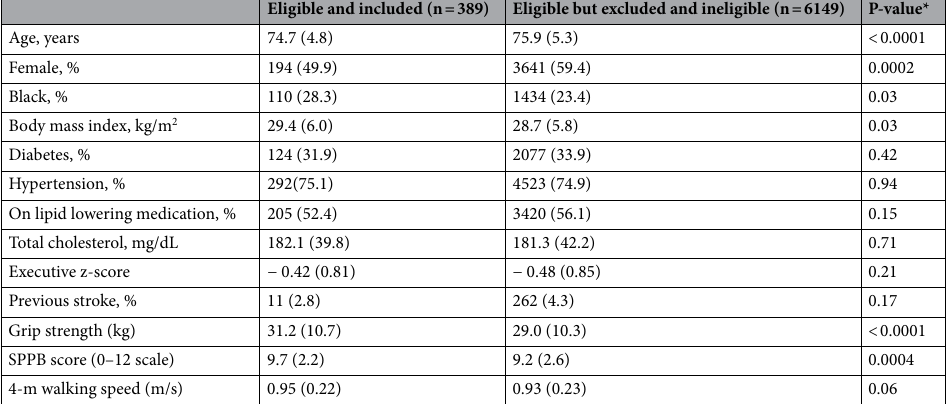
Table 1. Visit 5 characteristics of eligible and included and eligible but excluded and ineligible Atherosclerosis Risk in Communities (ARIC) Study participants (2011–2013). Data are shown as frequency (percentage) for categorical variables and as mean (standard deviation) for continuous variables. *All categorical p-values calculated using Wald chi-squared test and continuous using t-test.